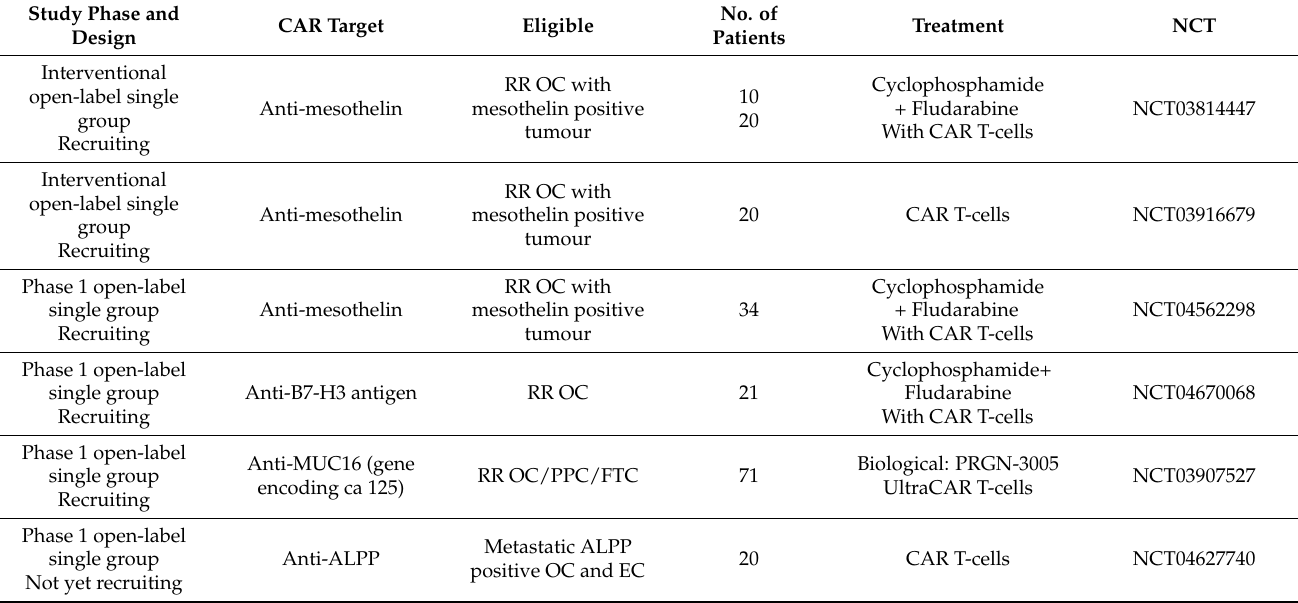
Table 2. Chimaeric antigen receptor (CAR) T-cell therapy clinical trials in ovarian